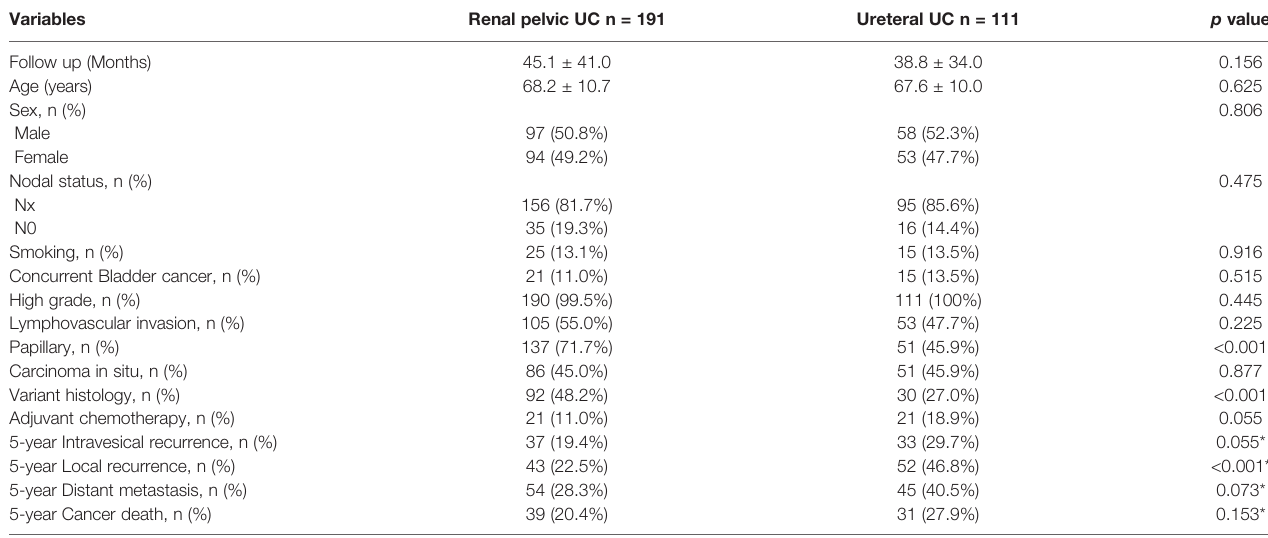
TABLE 1 | Clinicopathologic Characteristics for pT3N0M0